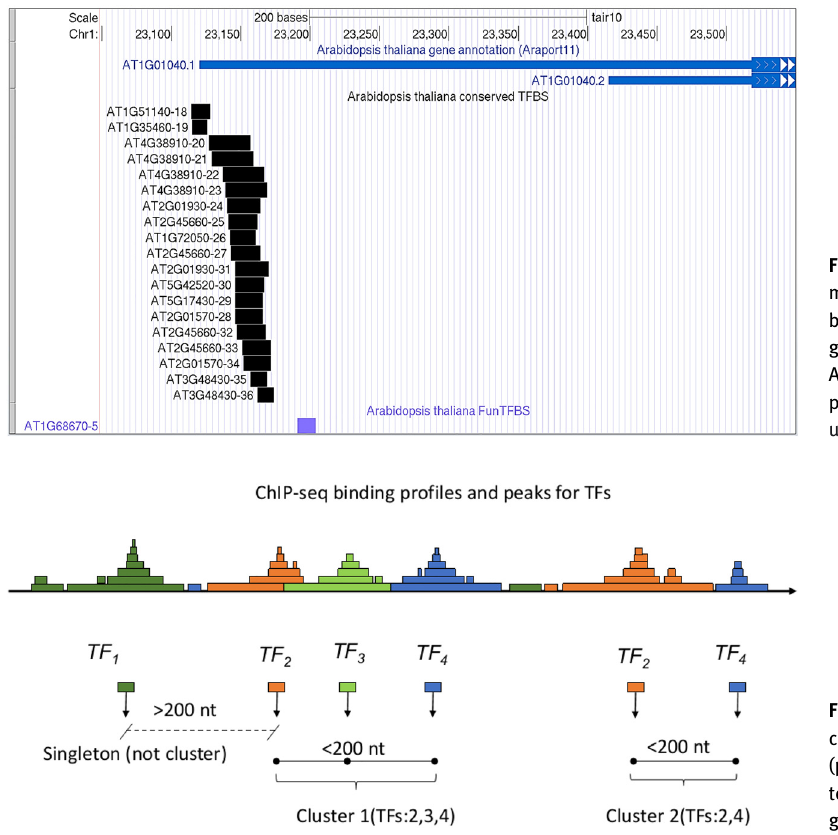
Figure 4: Example of the pro- cessing of ChIP-seq profiles (peaks) for the TFs binding to count binding clusters in genome